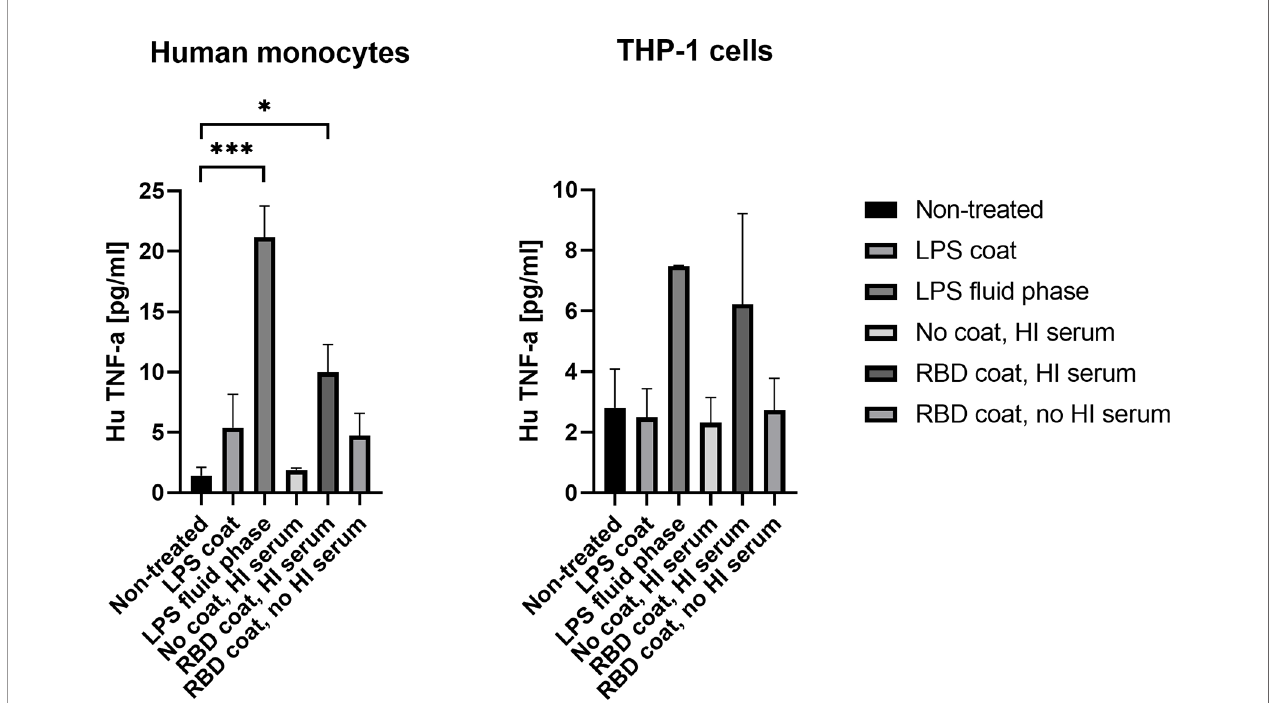
FIGURE 5 | Production of cytokine TNF- a in isolated human monocytes and THP-1 cells after stimulation with SARS-CoV-2 immune complexes. A p value < 0.05 was considered signi fi cant. *p < 0.05, ***p < 0.001 using an ordinary one-way-ANOVA with Holm-S ̌ ı ́ da ́ k ’ s multiple comparisons test.. Data are represented as mean values of three independent